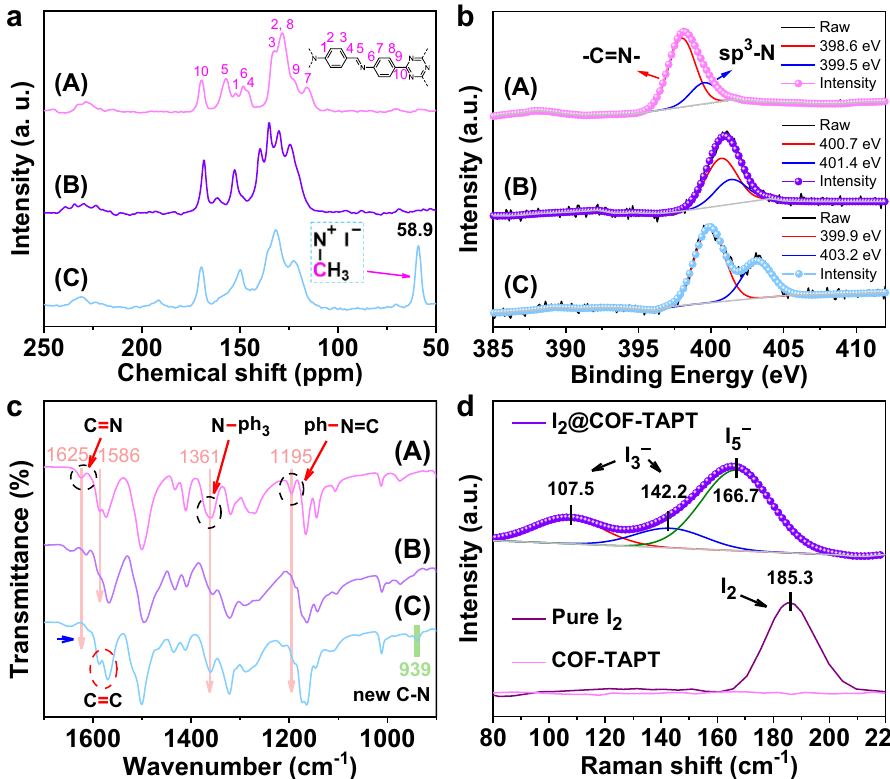
Fig. 6 Characterization of I 2 /adsorbent and CH 3 I/adsorbent interactions. a 13 C NMR spectra of (A) pristine, (B) I 2 -saturated, and (C) CH 3 I-saturated COF-TAPT. b N 1 s XPS spectra of (A) pristine, (B) I 2 -saturated, and (C) CH 3 I-saturated COF-TAPT. c FTIR spectra of (A) pristine, (B) I 2 -saturated, and (C)